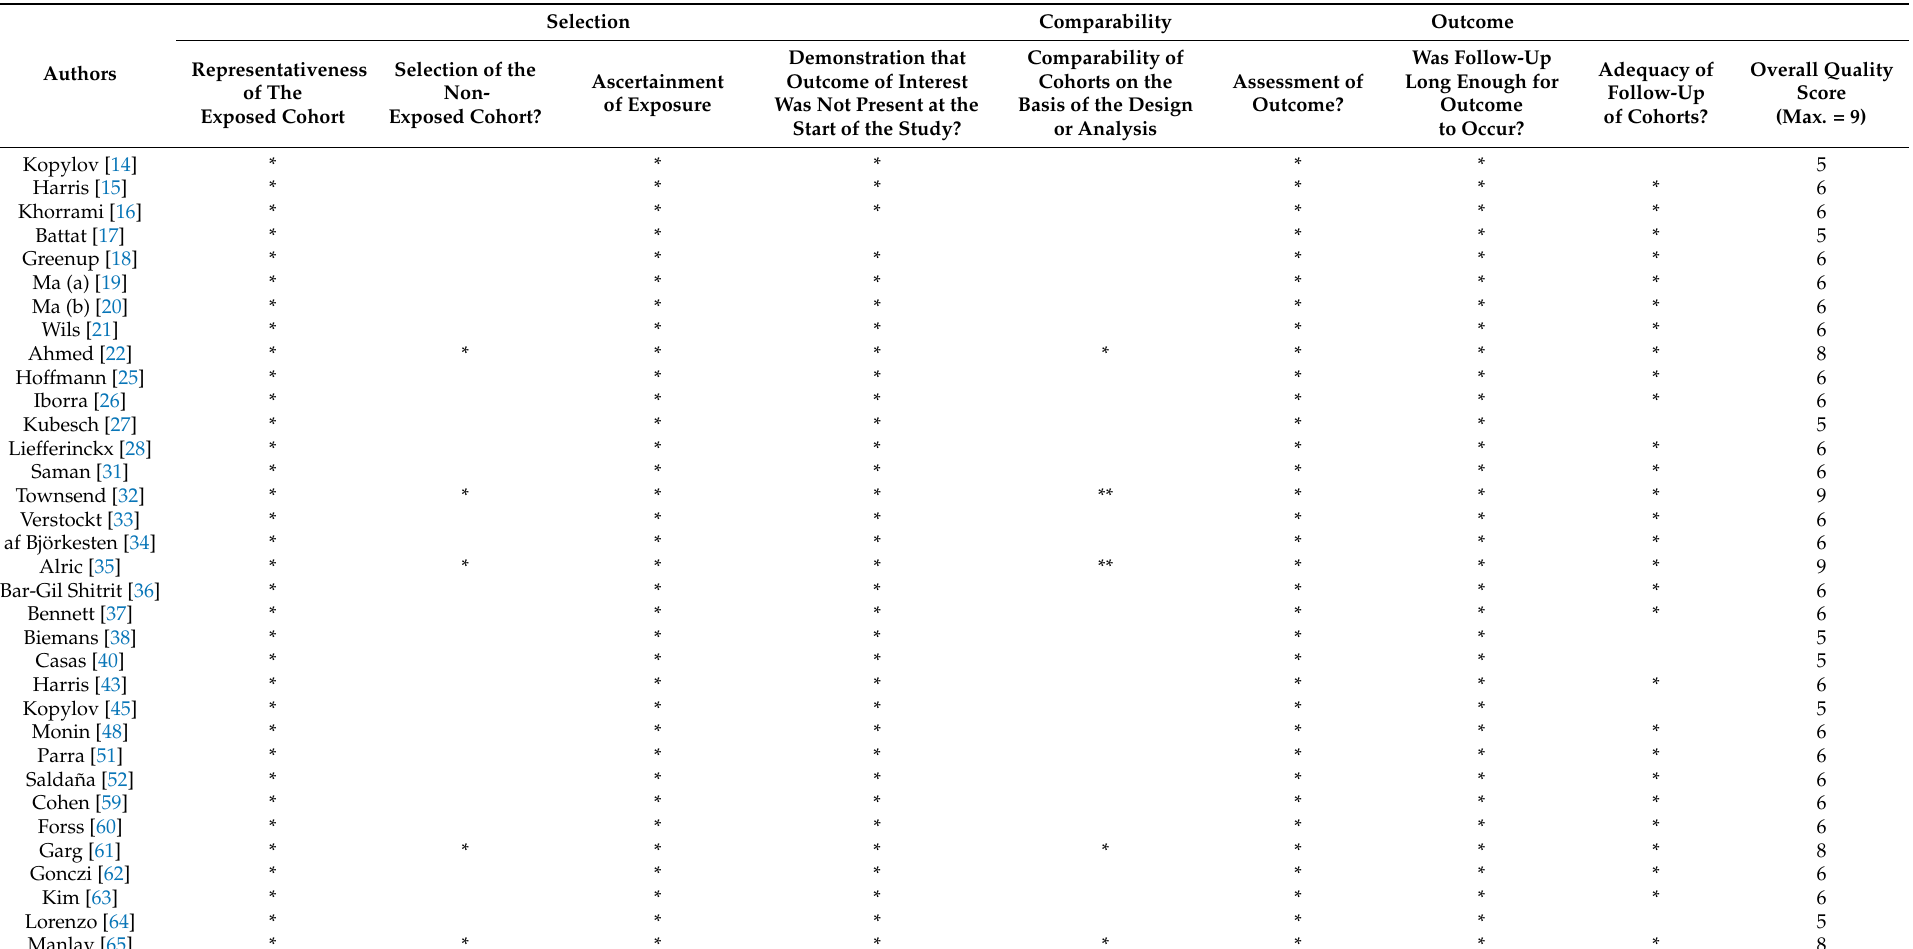
Table 5. Newcastle–Ottawa scale for assessment of quality of included studies (each asterisk represents when an individual criterion within the subsection was fulfilled, See Supplementary Figure